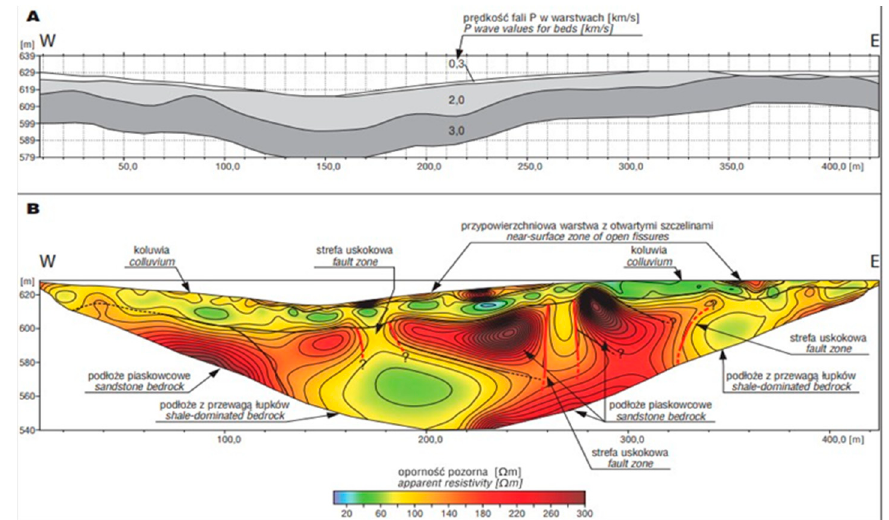
Figure 2. Transverse geophysical sections (subperpendicular to the landslide axis), Milówka. A : Seismic section obtained by means of the seismic refraction profiling method. B : Apparent resistivity section, obtained by means of the ERT method, with geological interpretation [10].